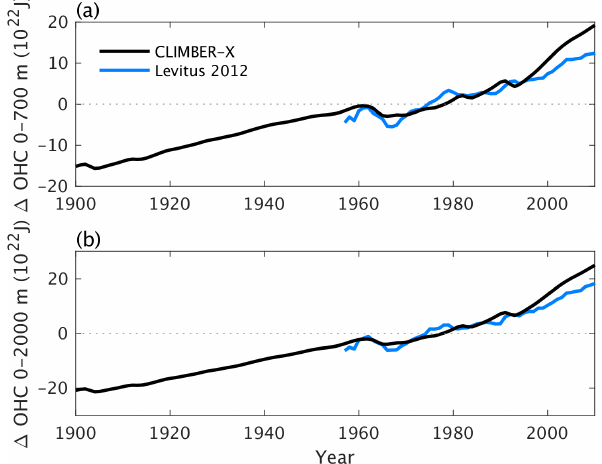
Figure 20. Historical ocean heat content anomalies in (a) the top 700m and (b) the top 2000m simulated by CLIMBER-X (black) and derived from observations (blue) (Levitus et al., 2012).